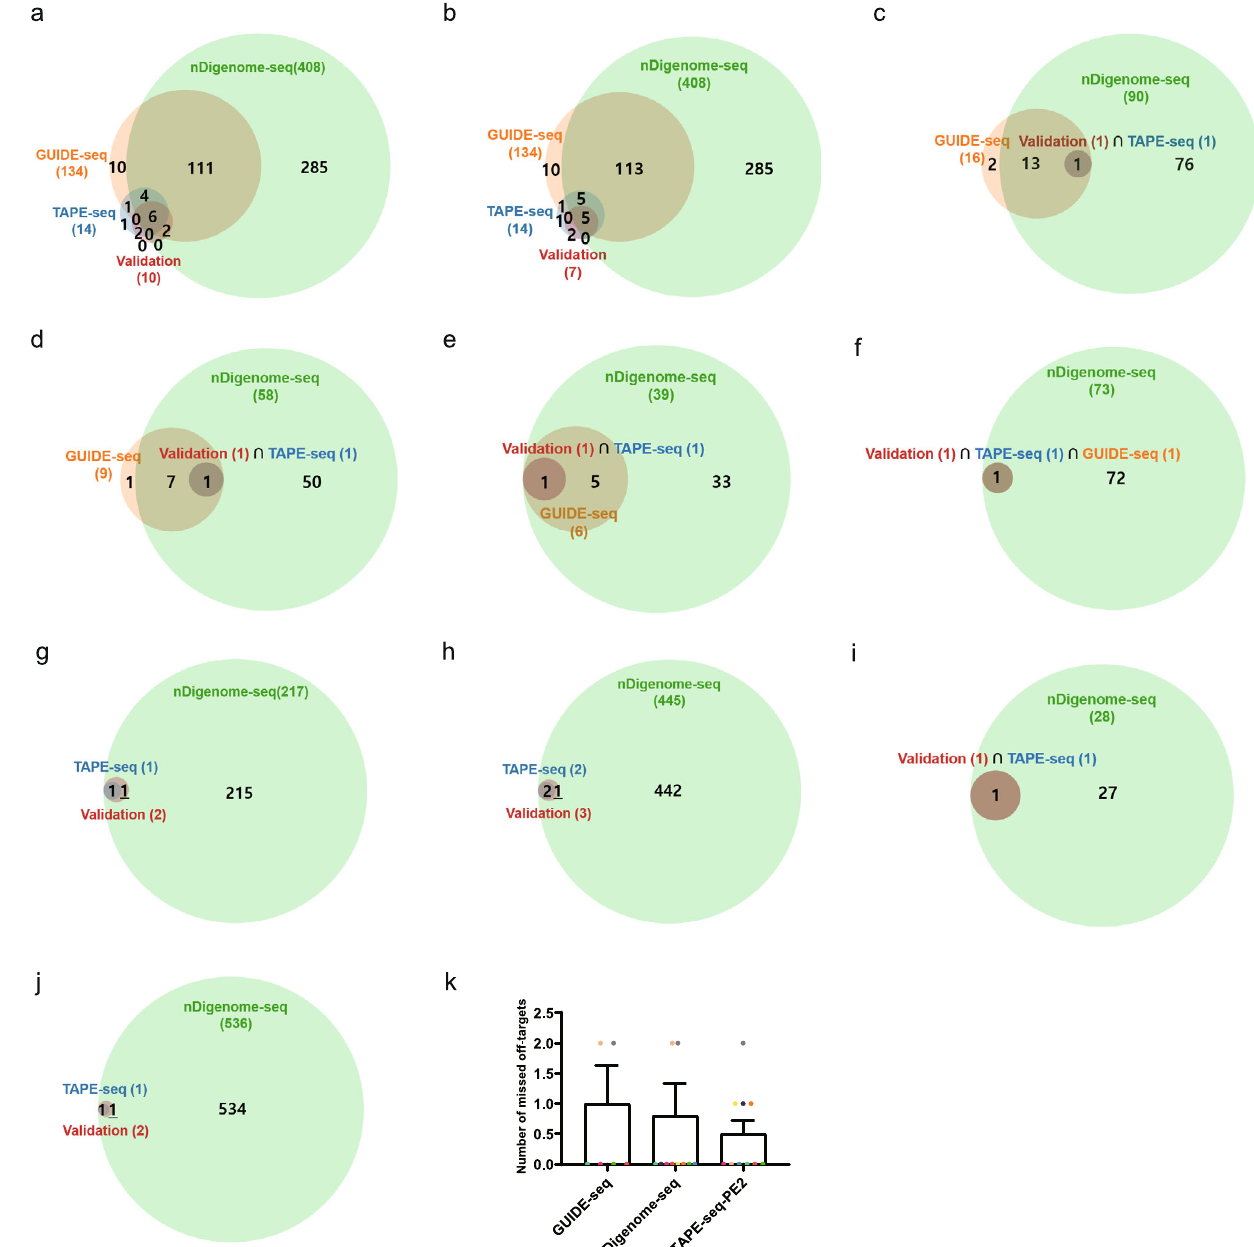
Fig.2|ComparisonsofTAPE-seqpredictionresultswiththosefromGUIDE-seq and nDigenome-seq. a – j Venn diagrams showing the number of and overlap betweenoff-targetlocipredictedbynDigenome-seq,GUIDE-seq,andTAPE-seqand validatedoff-targetsitesfor a HEK4 (+2GtoT), b HEK4 (+3TAAins), c EMX1 (+5Gto T), d FANCF (+6GtoC), e HEK3 (+1CTTins), f RNF2 (+6GtoA), g DNMT1 (+6GtoC), h HBB (+4A to T), i RUNX1 (+6G to C), and j VEGFA (+5G to T) pegRNAs. k